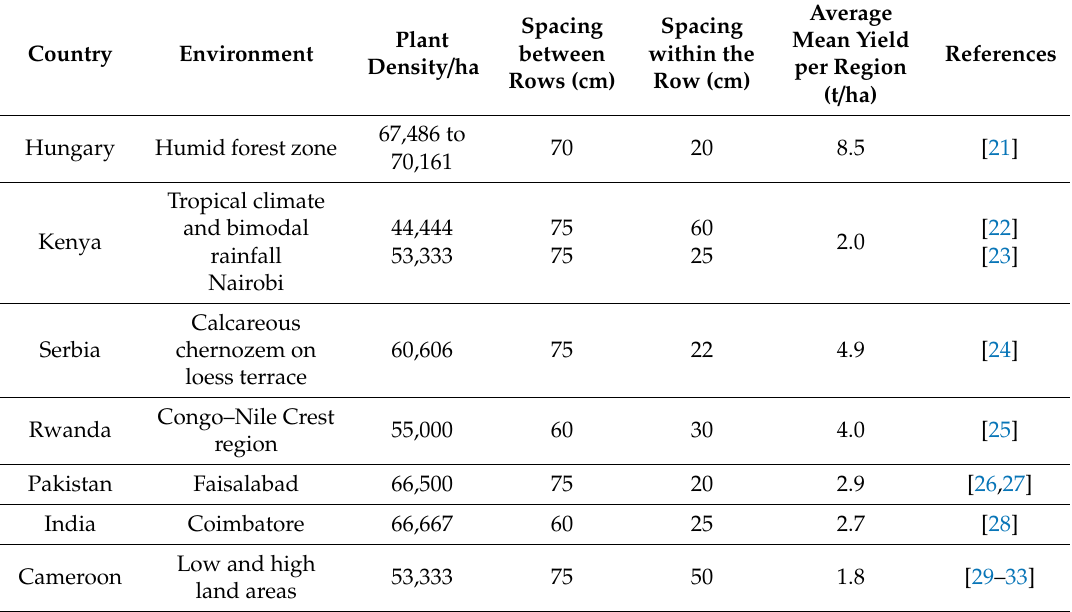
Table 1. Some plant densities and spacings used in various agro-ecological environments for maize